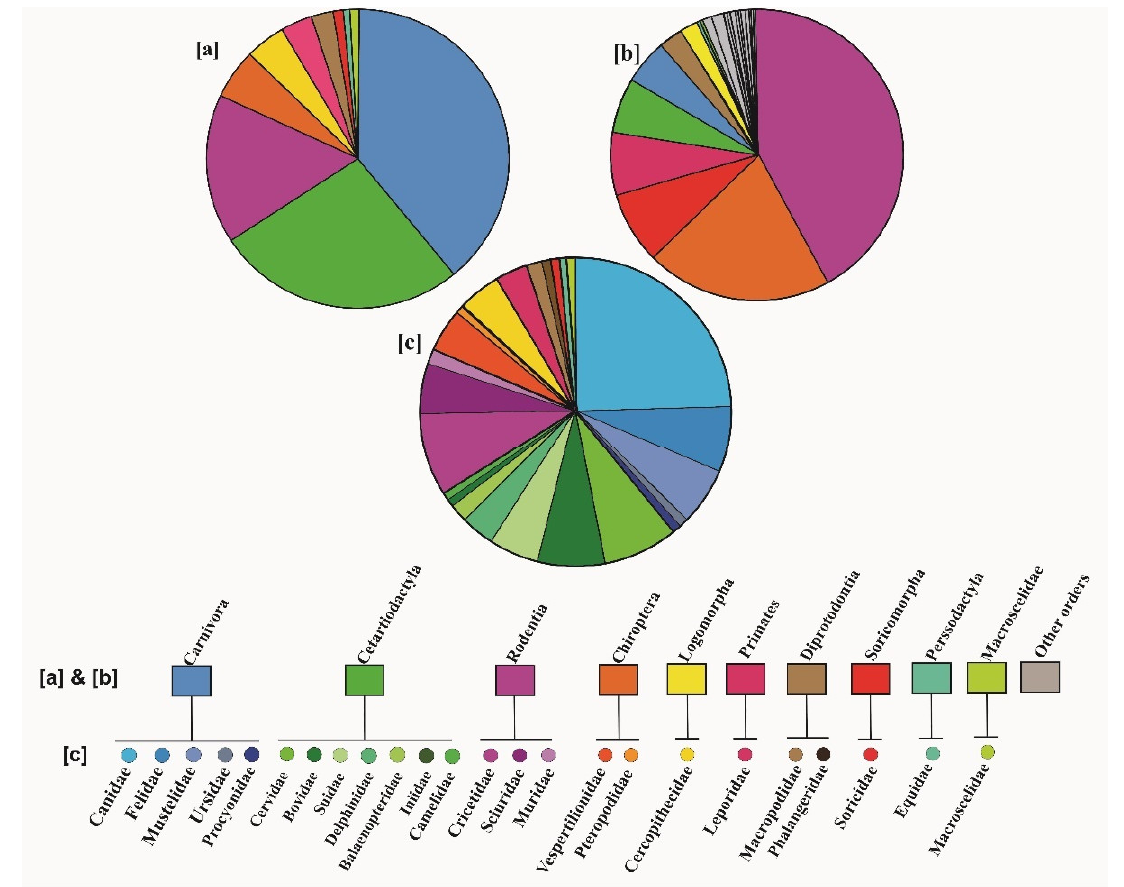
Figure 2. Relative frequencies of ( a ) orders represented in 115 papers included in the systematic review, ( b ) orders represented across all currently recognized mammalian species [62] and ( c ) families represented in 115 papers included in the systematic review.